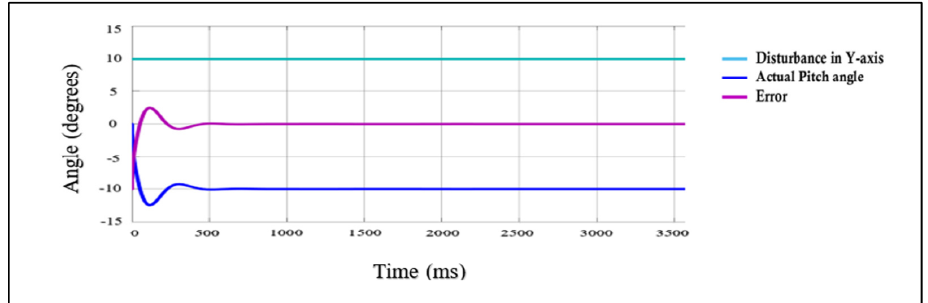
A. under tilt angle 10° on positive